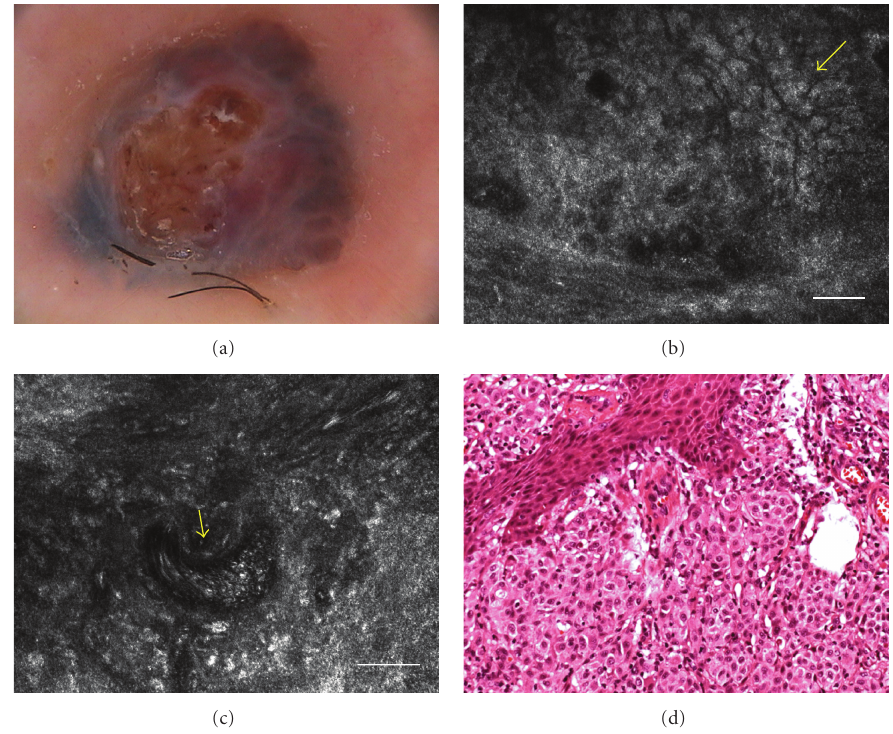
Figure 4: (a) Dermoscopy showed structureless areas with blue hue and a globular pattern. Ulceration was present in the center of the nodule (original magnification 30 × ). (b) RCM image (0 . 5 × 0 . 5 mm) at dermal level, showing pleomorphic small cells ( yellow arrow ) arranged to form a cerebriform nests delimitated by fibrous septa (scale bar: 50 µ m). (c) RCM image (0 . 5 × 0 . 5 mm) at dermal level, showing an enlarged new-born vessel with a prominent blood flow ( yellow arrow ) (scale bar: 50 µ m). (d) Histology showing a solid proliferation of atypical melanocytes in which new-born vessels can be recognized (H&E section; original magnification ×